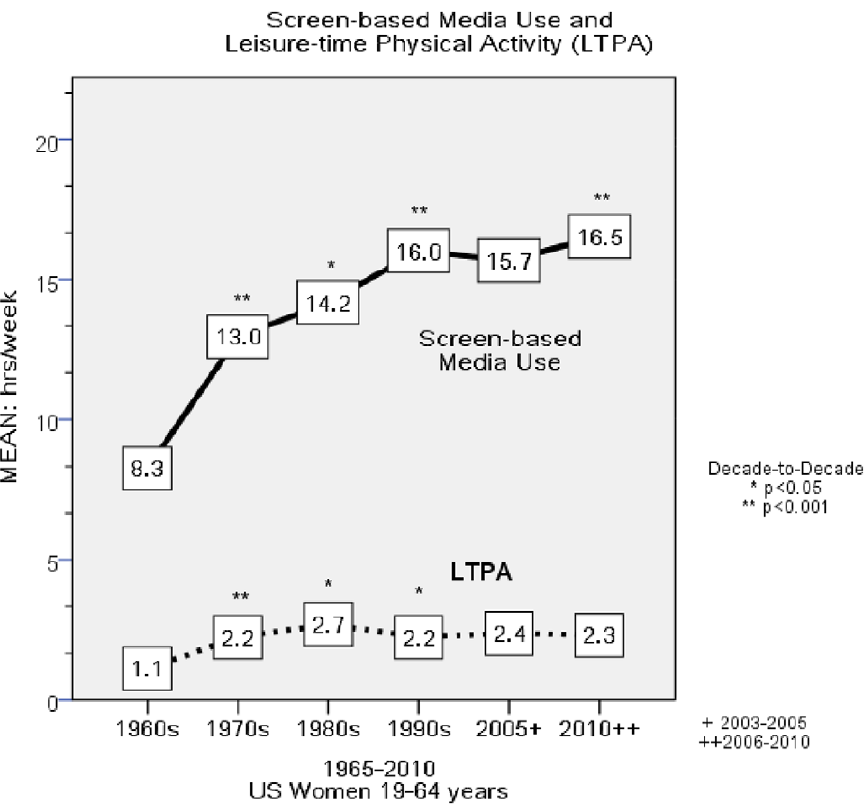
Figure 4. Screen-based Media Use & Leisure-Time Physical Activity. This figure depicts the decade to decade changes in Screen-based media use and Leisure-Time Physical Activity (LTPA) for all